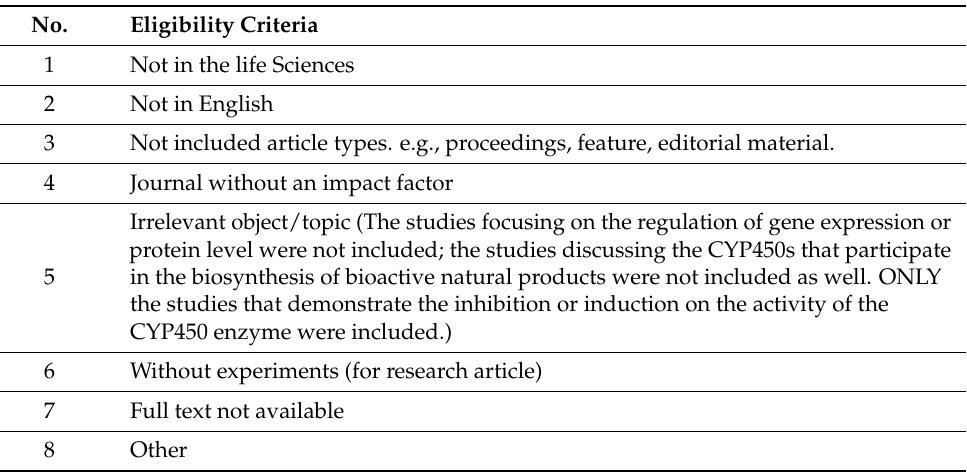
Table 3. Eligibility criteria of selected